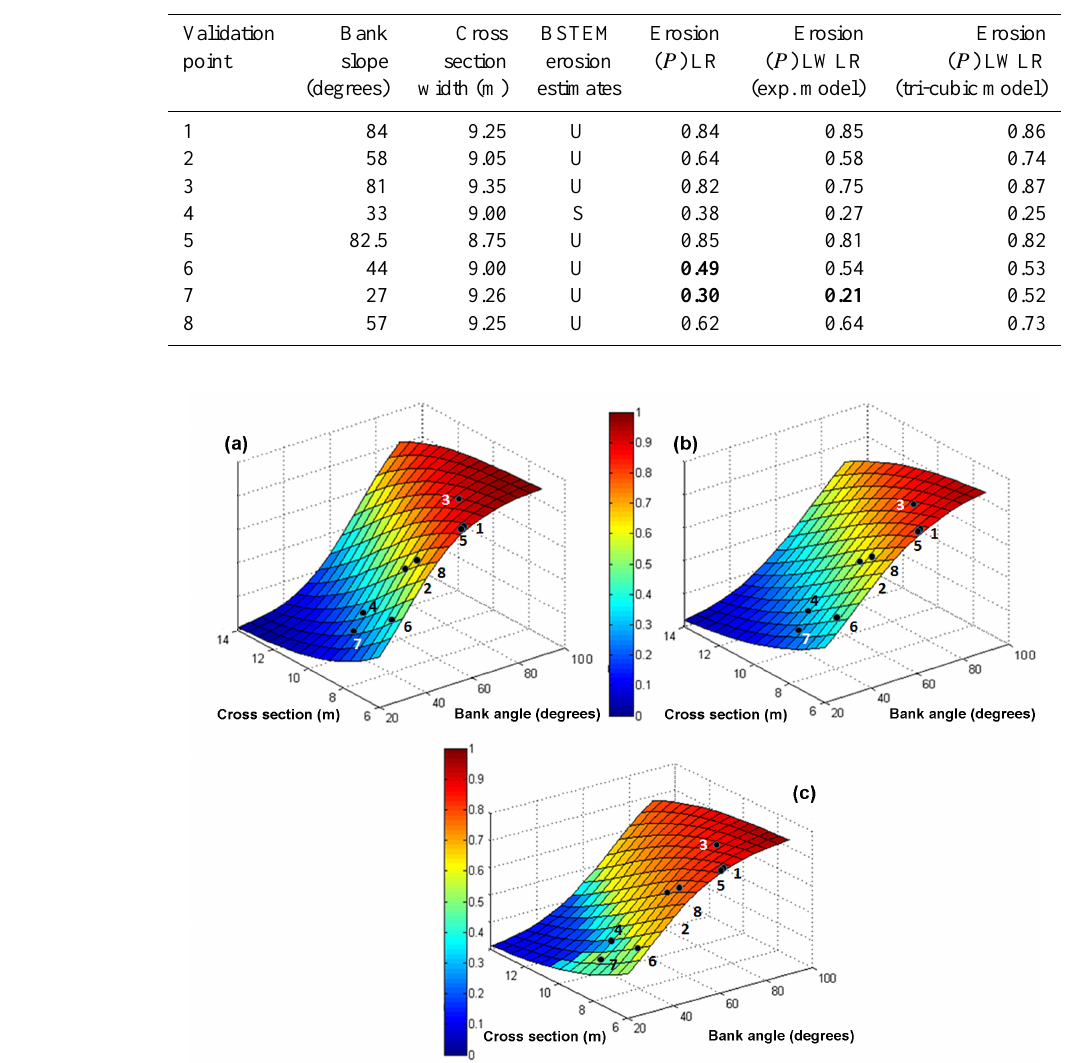
Table 4. Result of LWLR application at the eight validation locations (Fig. 1). The LR estimates, the independent variables used and the BSTEM estimates are also presented. The diverged values are indicated in bold. In the fourth column, S denotes stable and U unstable bank locations.